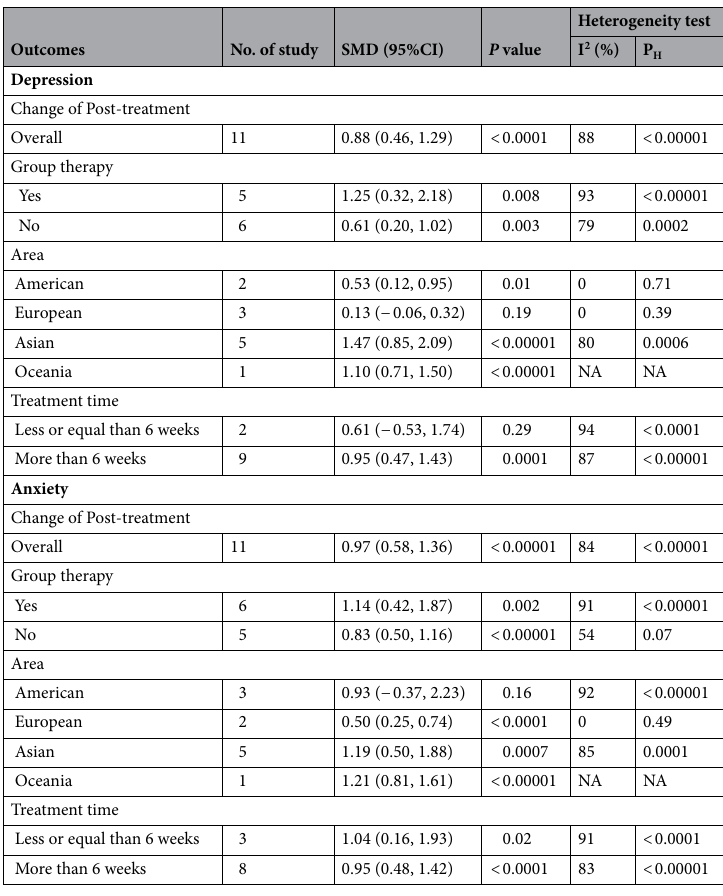
Table 2. Results of subgroup analyses. CI, confidence interval; NA, not available; SMD, Standardized mean difference.